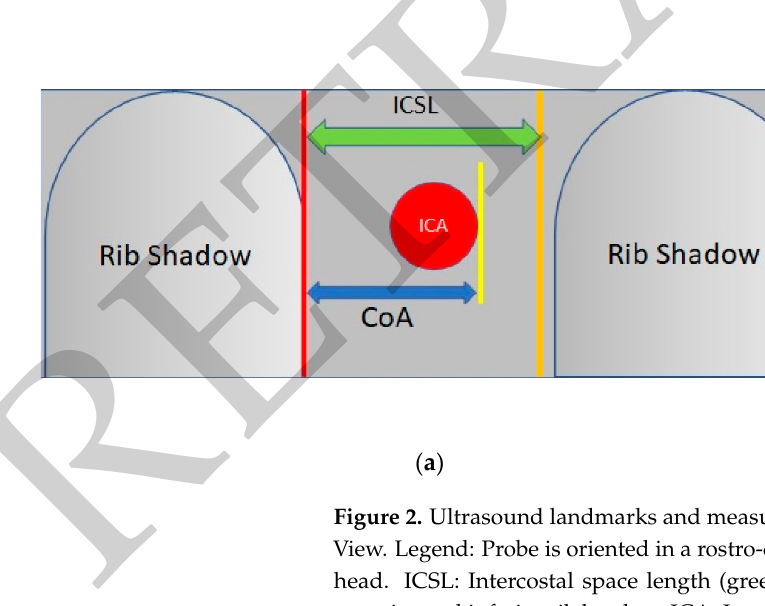
areas. Measurements were done using a paper ruler in cm, SpAi: (yellow arrow), distance between spinal column (Orange line) and initial entry of Intercostal artery into the intercostal space, SpAe: (Orange Arrow) distance between spinal column and exit of intercostal artery from the intercostal